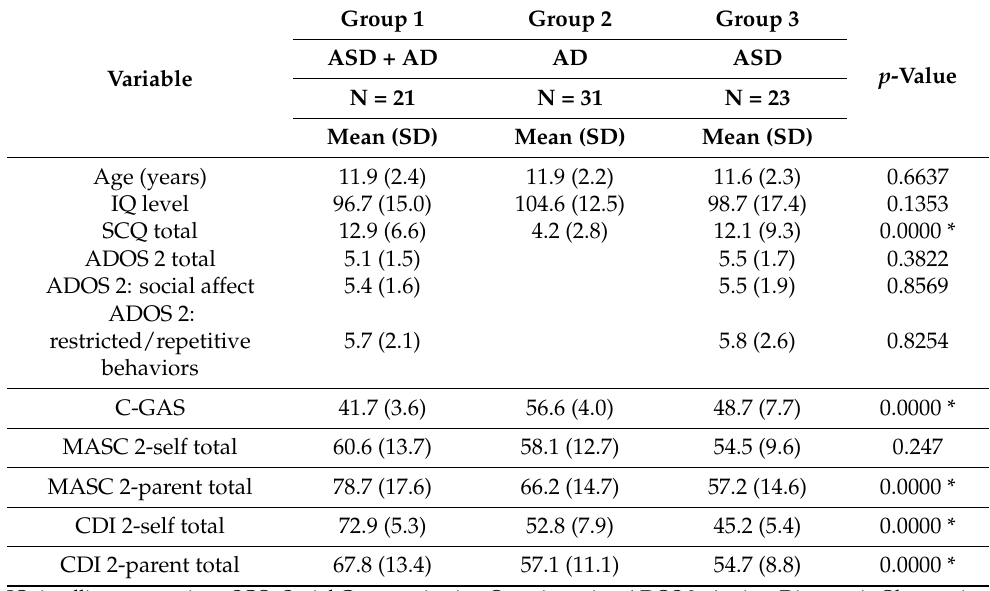
Table 1. Socio-demographic characteristics and children and adolescent assessment data scores separately for three